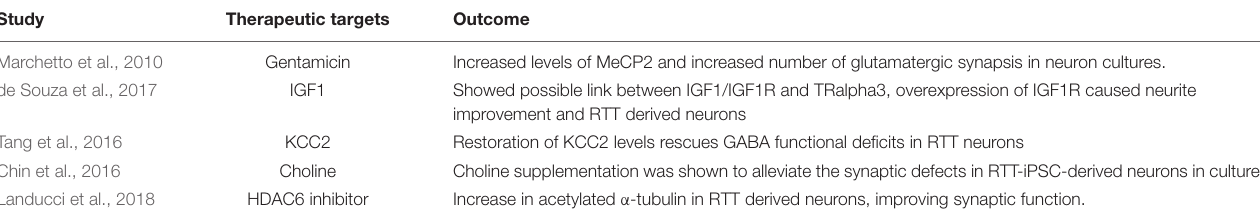
TABLE 2 | Summary of therapeutic targets and